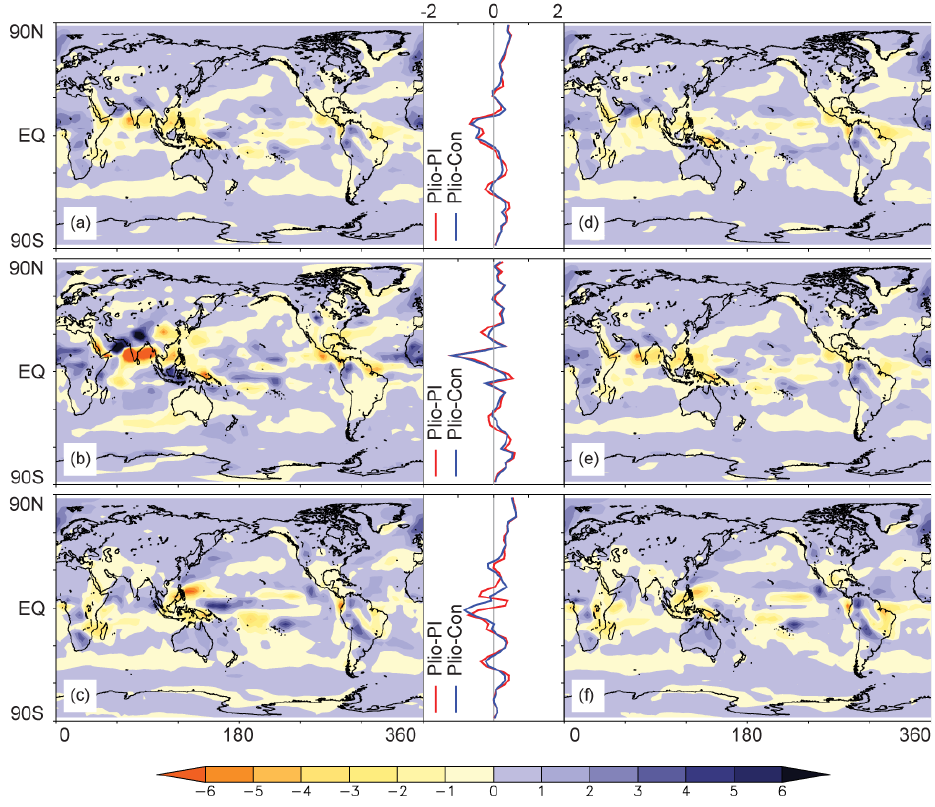
Fig. 7. Precipitation anomalies (mm d − 1 ) , left column for the anomalies between the mid-Pliocene and the pre-industrial experiment, right column for the anomalies between the mid-Pliocene and the control experiment. (a) and (d) for annual mean, (b) and (e) for boreal summer, and (c) and (f) for boreal winter. The bold lines in the middle show zonal mean values.